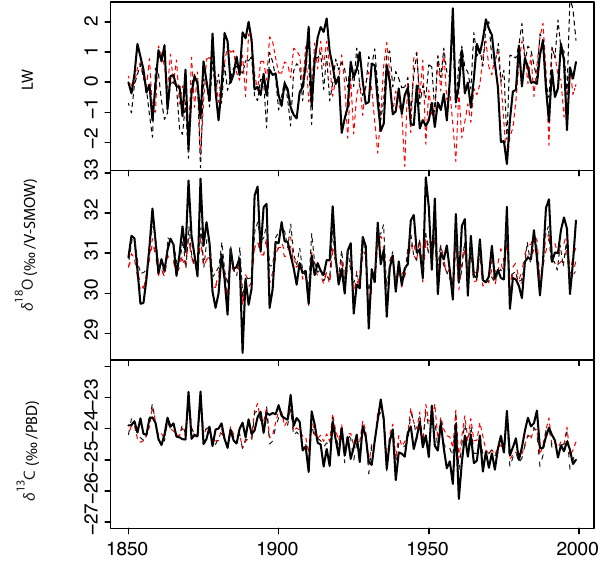
Figure 4. Observed and simulated tree ring proxies. Black bold lines represent observed latewood widths (LW), δ 18 O and δ 13 C of tree ring α cellulose. Black dotted lines correspond to the simula- tions performed from the A1 (increasing CO 2 ) scenario, while red dotted lines represent the A2 (stable CO 2 ) scenario.